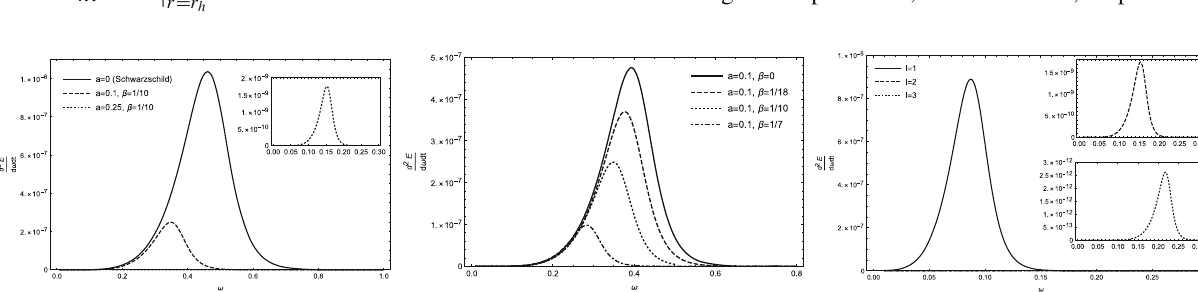
Fig. 9 For β > 0 and M = 1, the left-figure is the power emission The right-figure is the power emission spectra taken l as the variable at a = 0 . 25 and β = 1 spectra taken a as the variable at β = 1 , l = 2. The center-figure is 10 the power emission spectra taken β as the variable at a = 0 . 1, l = 2.